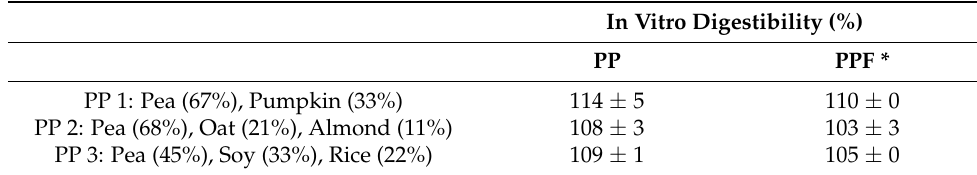
Table 2. In vitro protein digestibility of plant protein (PP) and plant protein fibre (PPF) products 1 . In Vitro Digestibility